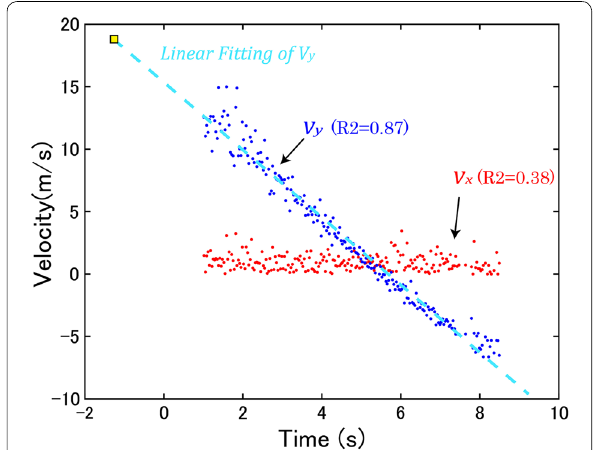
Fig. 4 An example of the velocity profile obtained from trajectory data. Red dots show the velocity in the horizontal direction, and blue dots show the velocity in the vertical direction. A light blue line shows the linear fitting of the vertical velocity, and the R 2 value in the figure is its correlation coefficient. The vertical velocity at the vent height, shown with a yellow square, is estimated by extrapolating this linear fitting